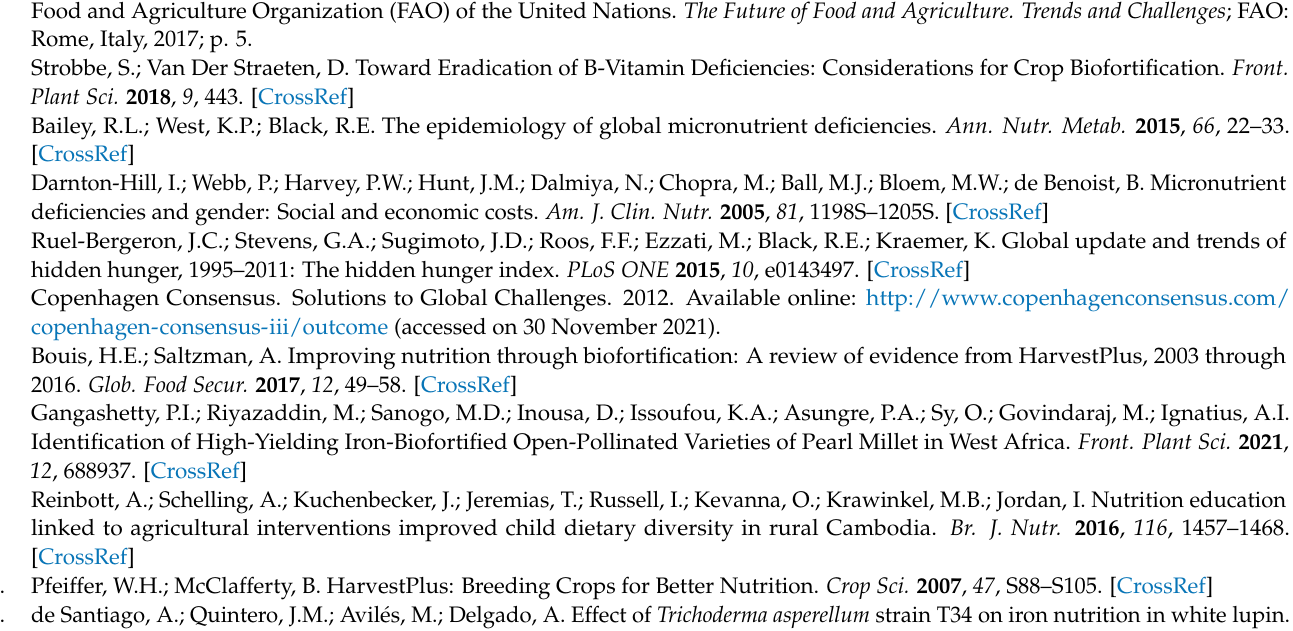
Table S2: Treatments performed in experiment #C with Trichoderma strains (T22, TH1, GV41) or metabolites (HA, 6PP,